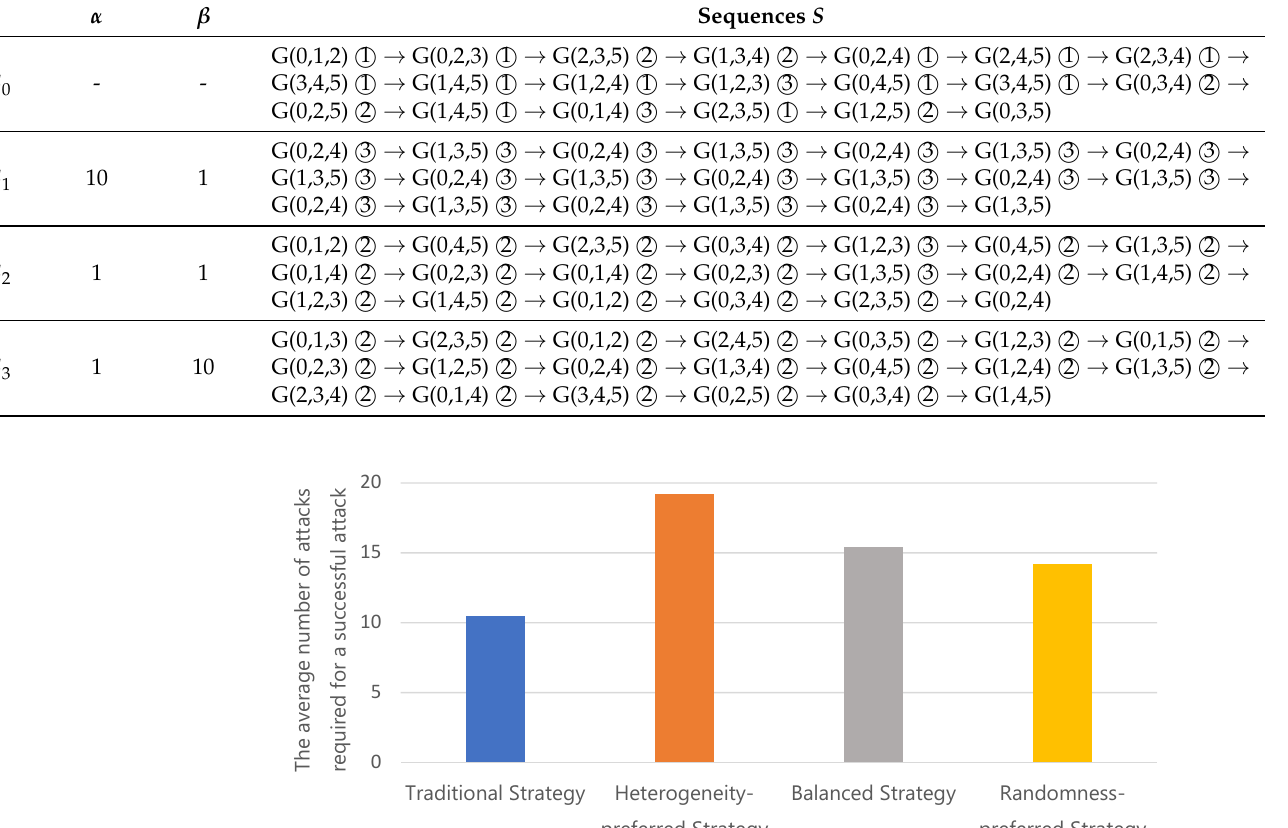
Table 4. The image replacement sequence generated from the MDSF scheduling strategies.